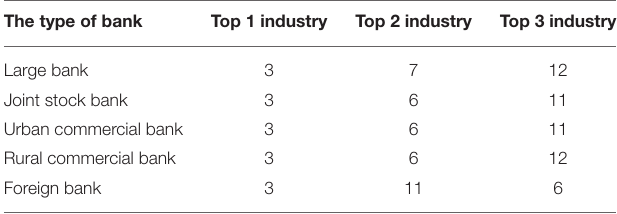
TABLE 3 | Top three real industries with the most loans from banks (the figure in the table is the industry